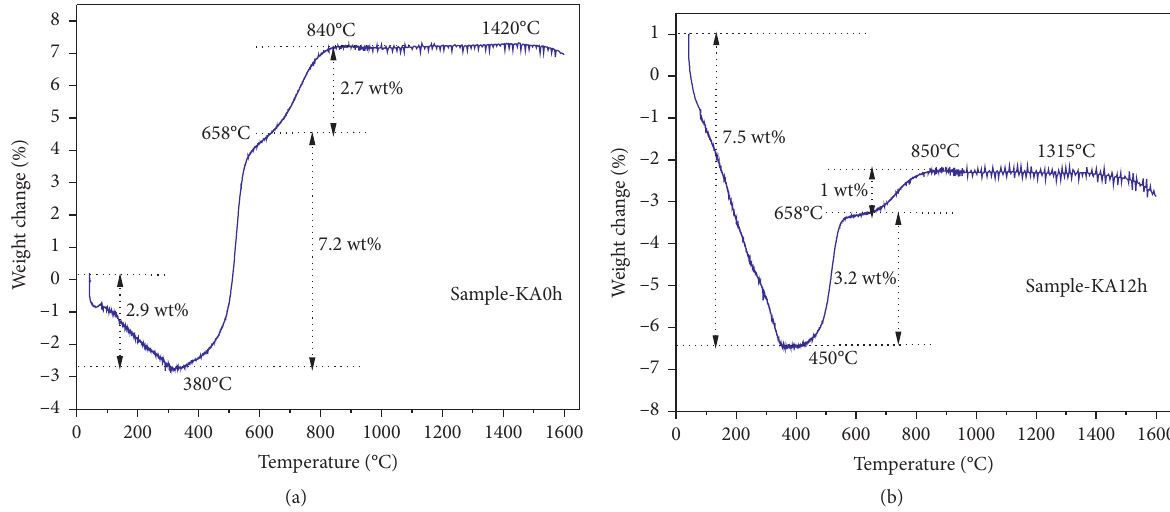
Figure 7: Thermogravimetric behavior of samples KA0h (a) and KA12 h (b).